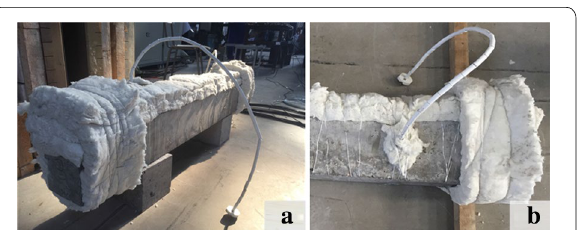
Fig. 3 Three-sided fire exposure and thermocouple layout